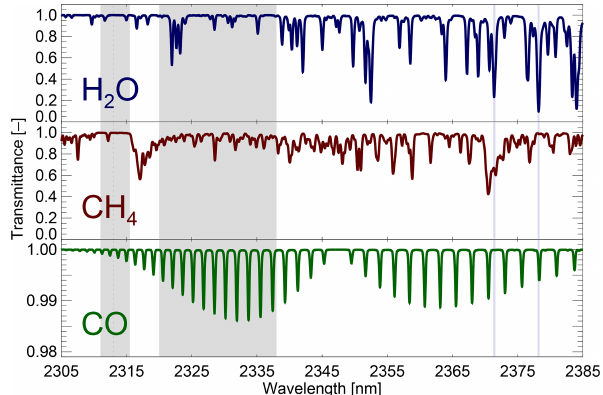
Figure 1. Fitting windows (grey, 2311–2315 . 5 and 2320–2338nm) and trace gas transmittances for the SWIR bands of TROPOMI for US Standard Atmosphere concentrations. The strong H 2 O absorp- tion lines between 2370 and 2380nm used to obtain cloud informa- tion are shown in light blue . The apparent albedo is retrieved in the continuum at 2313nm (dashed line).